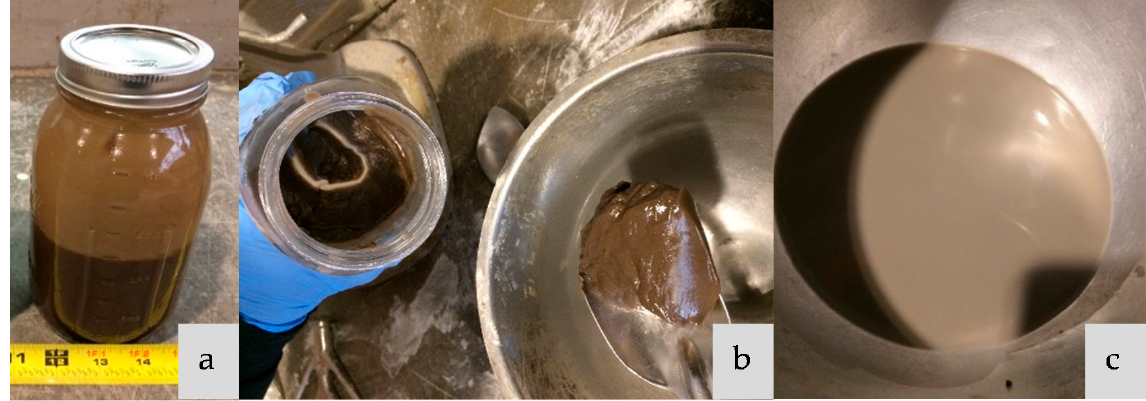
Figure 2. Ash treatment process (this process was used for SF-T, RSA-T, and RHA-T); ( a ) ash being soaked in NaOH; ( b ) ash after 24 h soaking; ( c ) dispersed treated ash in the activator solution.